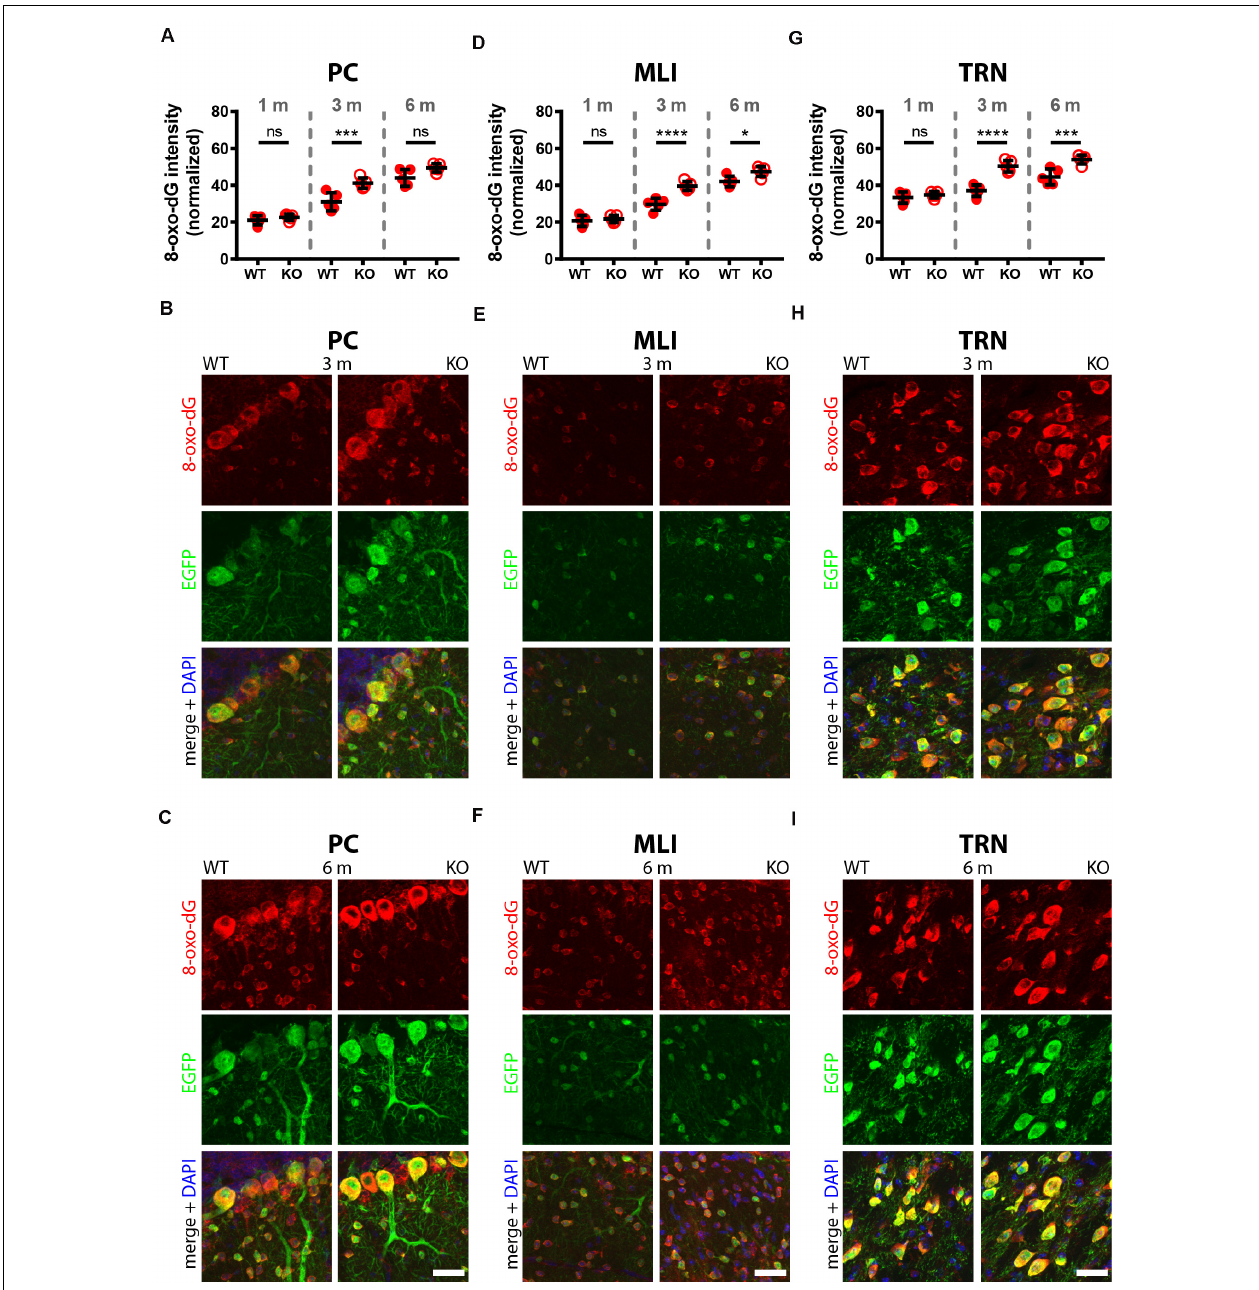
FIGURE 4 | Comparison of 8-oxo-dG signal intensity in cerebellum (PC, MLI) and TRN of 1, 3, and 6-months old WT and KO mice. Normalized 8-oxo-dG fluorescence signal intensities (a.u.) analyzed in PC (A) , MLI (D) , and TRN Pvalb neurons (G). Representative images with immunofluorescence labeling for 8-oxo-dG (red), EGFP (green) and merged + DAPI (blue) in PC from 3 (B) and 6-months old (C) mice are shown. In (E,F) the same is shown for MLI; and in (H,I) for TRN Pvalb neurons in WT (left panels) and KO (right panels) mice. Scale bars: 30 µ m. Each dot in the graphs represents the average obtained in 1 animal (5 mice per genotype) and at least 20 cells per animal resulting in > 100 cells per brain region (PC, MLI, TRN) and genotype. ns not significant; * p < 0.05; ** p < 0.01; *** p < 0.001; ∗∗∗∗ p < 0 . 0001. Values are reported in Table 1 .